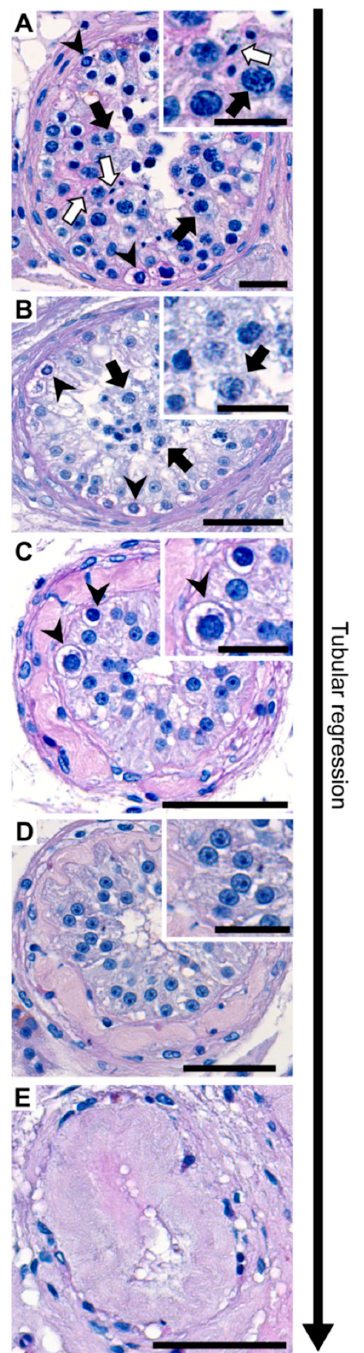
Figure 2. Histological findings showing stages of tubular regression in testicular tissues of transgender patients. Representative periodic acid-Schiff stained seminiferous tubules. ( A ) Tubule with complete spermatogenesis contains different types of germ cells. Spermatogonia (arrowhead), spermatocytes (black arrow) and elongated spermatids (white arrow). ( B ) In meiotic arrest spermatogonia (arrowhead) and spermatocytes (black arrow) are present. ( C ) Spermatogonial arrest shows only spermatogonia (arrowhead). ( D ) Sertoli cell only phenotype without germ cells. ( E ) Tubular shadow without any cells in the lumen. Tubular regression is described from A–E.